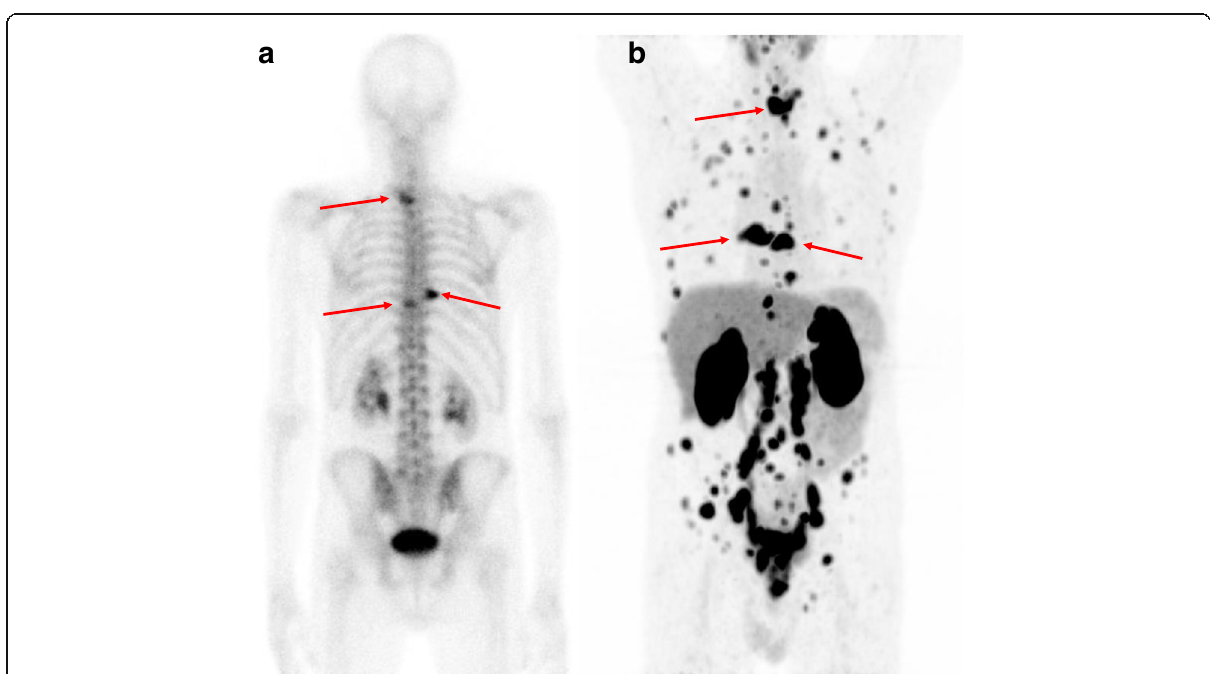
Fig. 4 Example of a patient (PSA 8 ng/mL, Gleason score 9, T3) with three bone metastases (shown by the arrows) on BS (shown in posterior